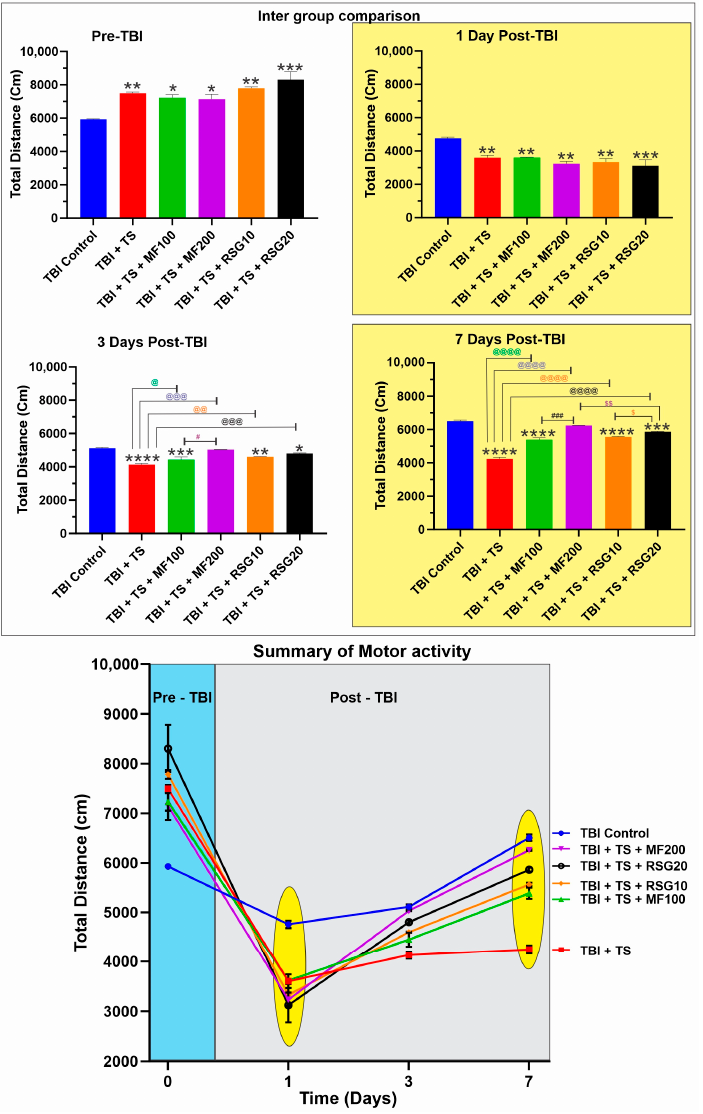
Figure 8. Effect of MF and RSG on exploratory behavior and general motor activity after premorbid TS exposure and TBI induction of mice. Mice undergoing chronic TS exposure demonstrated significantly higher motor activity. Measurements performed at 24 h, 3 days, and 7 days post-TBI showed that TS further aggravated TBI injury as denoted by the significant reduction in motor activity compared to the control. However, an assessment of the mice’s response to TBI and TS exposure w/wo MF and RSG showed that treated mice experienced a recovery in motor activity compared to non-treated animals. n = 6 biological replicates, * p < 0.05, ** p < 0.01, *** p < 0.001, **** p < 0.0001 versus control. @ p < 0.05, @@ p < 0.01, @@@ p < 0.01, @@@@ p < 0.0001 non-treated versus MF/RSG-treated group. # p < 0.05, ### p < 0.001 MF100 versus MF200. $ p < 0.05, $$ p < 0.01 RSG10 versus RSG20.